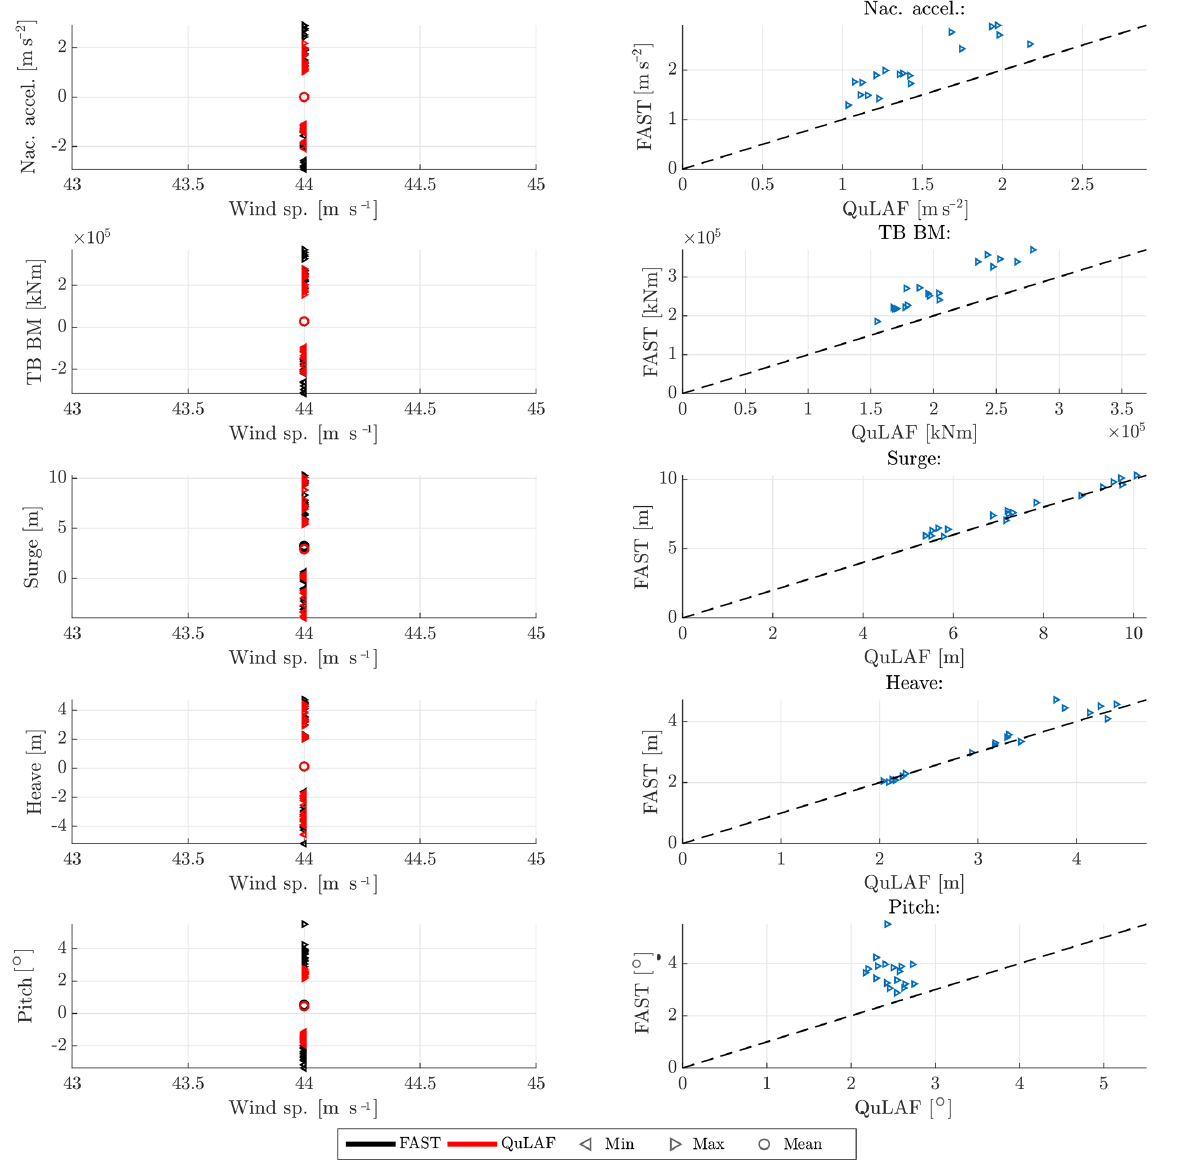
Figure 8. Response to DLC 6.1 for FAST and QuLAF. Left: min., max. and mean values for every realization as a function of wind speed. Right: maximum values for FAST as a function of the corresponding maximum values in